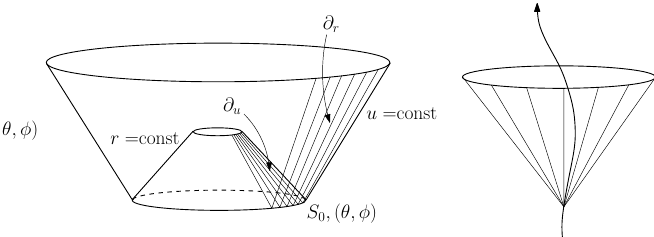
Figure 1 . Left: set-up of the characteristic 2 + 2 initial-value problem. Two null hypersurfaces intersect on a space-like 2d surface S 0 . When the two null hypersurfaces are intersecting light cones, as in the picture, S 0 has topology of a sphere. The (partial) Bondi gauge is such that ( (cid:18); (cid:30) ) are constant along @ r , and @ r is null for all values of u . On the other hand, @ u is null at at most one value of r , unless the spacetime has special isometries. Right: further requiring suitable regularity conditions one can consider also a local 3 + 1 foliation of light-cones generated by a time-like